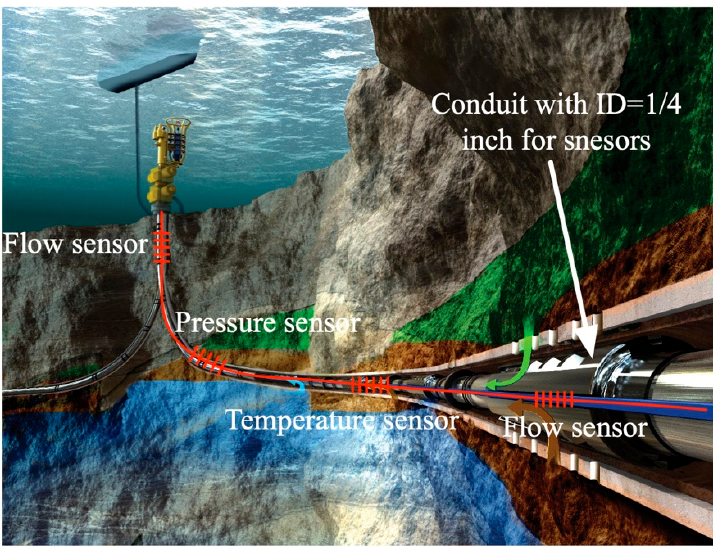
Figure 5. Schematic of a fiber optic sensing system for submarine oil exploitation (permission obtained from [111]).